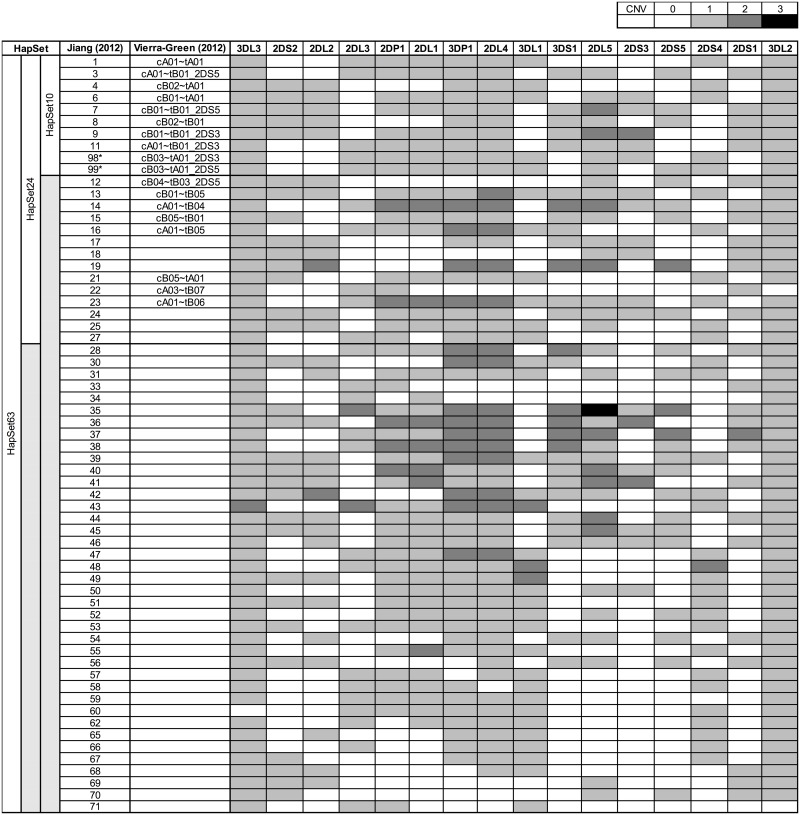
Reference haplotype sets.Each of 63 haplotypes depicted as copy number variants of 16 KIR genes. Copy number is labeled as shades of grey, where white boxes indicate 0 copies, and the darkest shade of grey indicates the highest variant number: 3. The haplotypes are primarily from individuals of European descent. a) HapSet10: 10 haplotypes from a study of 12 unrelated individuals. b) HapSet24: haplotypes with a frequency of > = 0.1% from Jiang et al. c) HapSet63: all haplotypes from Jiang et al. Haplotypes are labeled by number from the original publication and via Vierra-Green nomenclature when applicable. * cB03~tA01 is not in Jiang 2010; its KIR2DS3 and KIR2DS5 variants are arbitrarily labeled as 98 and 99. Note, haplotypes 2, 5 and 10 from Jiang (2012) represent alternative forms of gene content haplotypes based on allelic variation of KIR2DS4 (1, 4 and 6 respectively) and are, therefore, not included in the table.